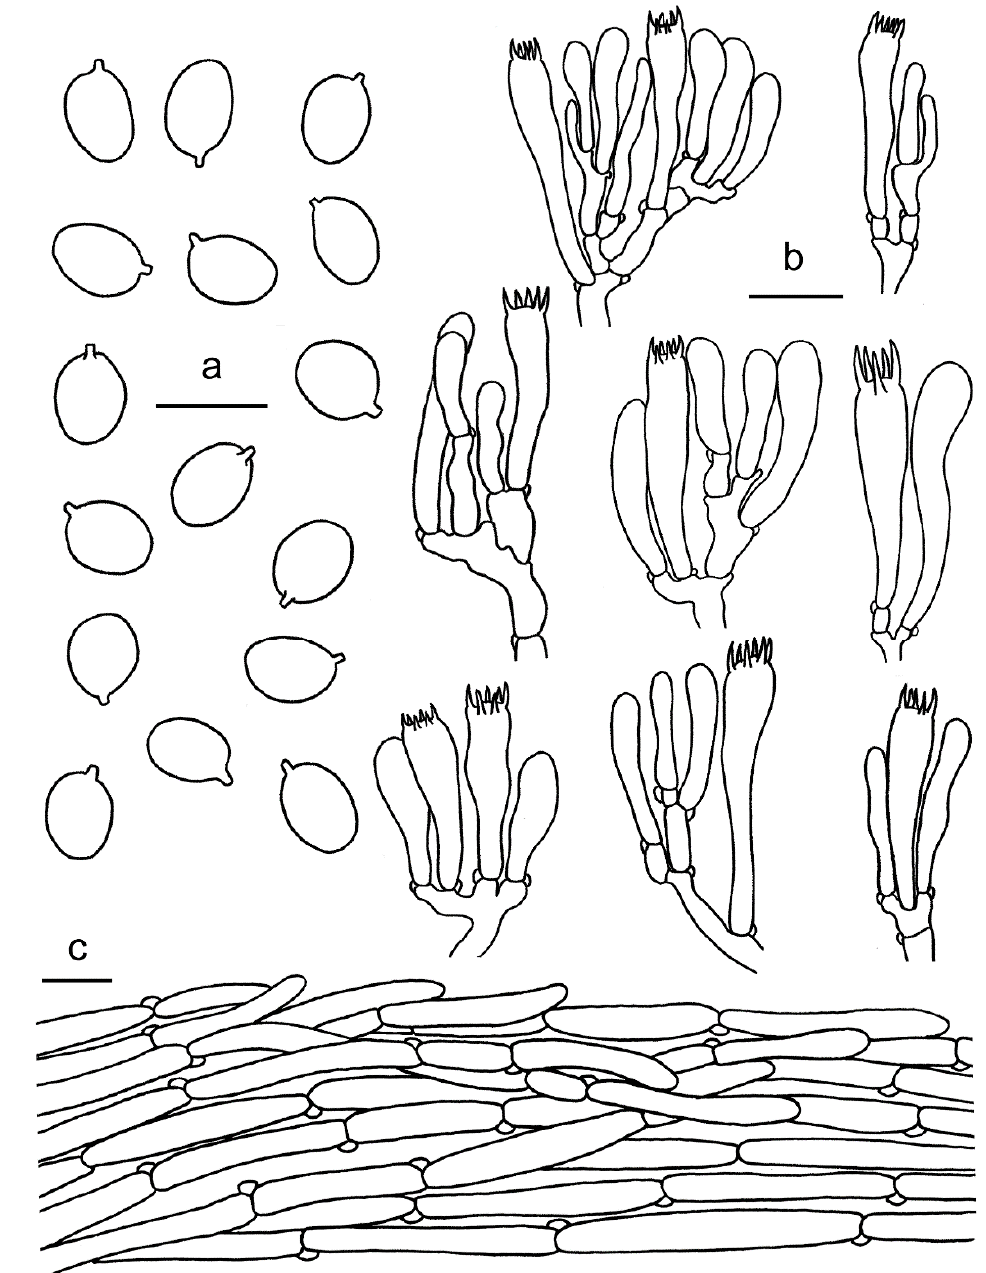
Figure 13. Cantharellus sinominor (GDGM80842, Holotype!). ( a ) Basidiospores. ( b ) Basidia, basidiola and elements of the subhymenium. ( c ) Pileipellis. Bars: ( a ) = 10 μ m; ( b – c ) = 20 μ m. Basidiomata small-sized. Pileus 10–23 mm broad, applanate with center depressed, not perforate, margin incurved when young, applanate or slightly reflexed with age, obscure striate on surface; subfleshy to slightly membranous; surface dry, subtomentosus, greyish yellow to greyish orange at central (3B4–5B4), gradually fading to light yellow to light orange toward margin (3A4–5A4). Context thin, 0.5–1.2 mm thick in the center of the pileus, fibrous, pale yellow to pale orange (3A3–5A3), unchanging when bruised. Hymenophore decurrent, distant to subdistant, well developed, gill-liked ridges 1–1.5 mm high, mostly forked at margin, greyish yellow to greyish orange (3B5–5B5), unchanging when bruised. Stipe 30–50 mm long, 2–3 mm thick, subcylindrical, slightly tapering downward, smooth or with faintly scaly, hollow, concolourous to pileus. Odour none, Taste mild.